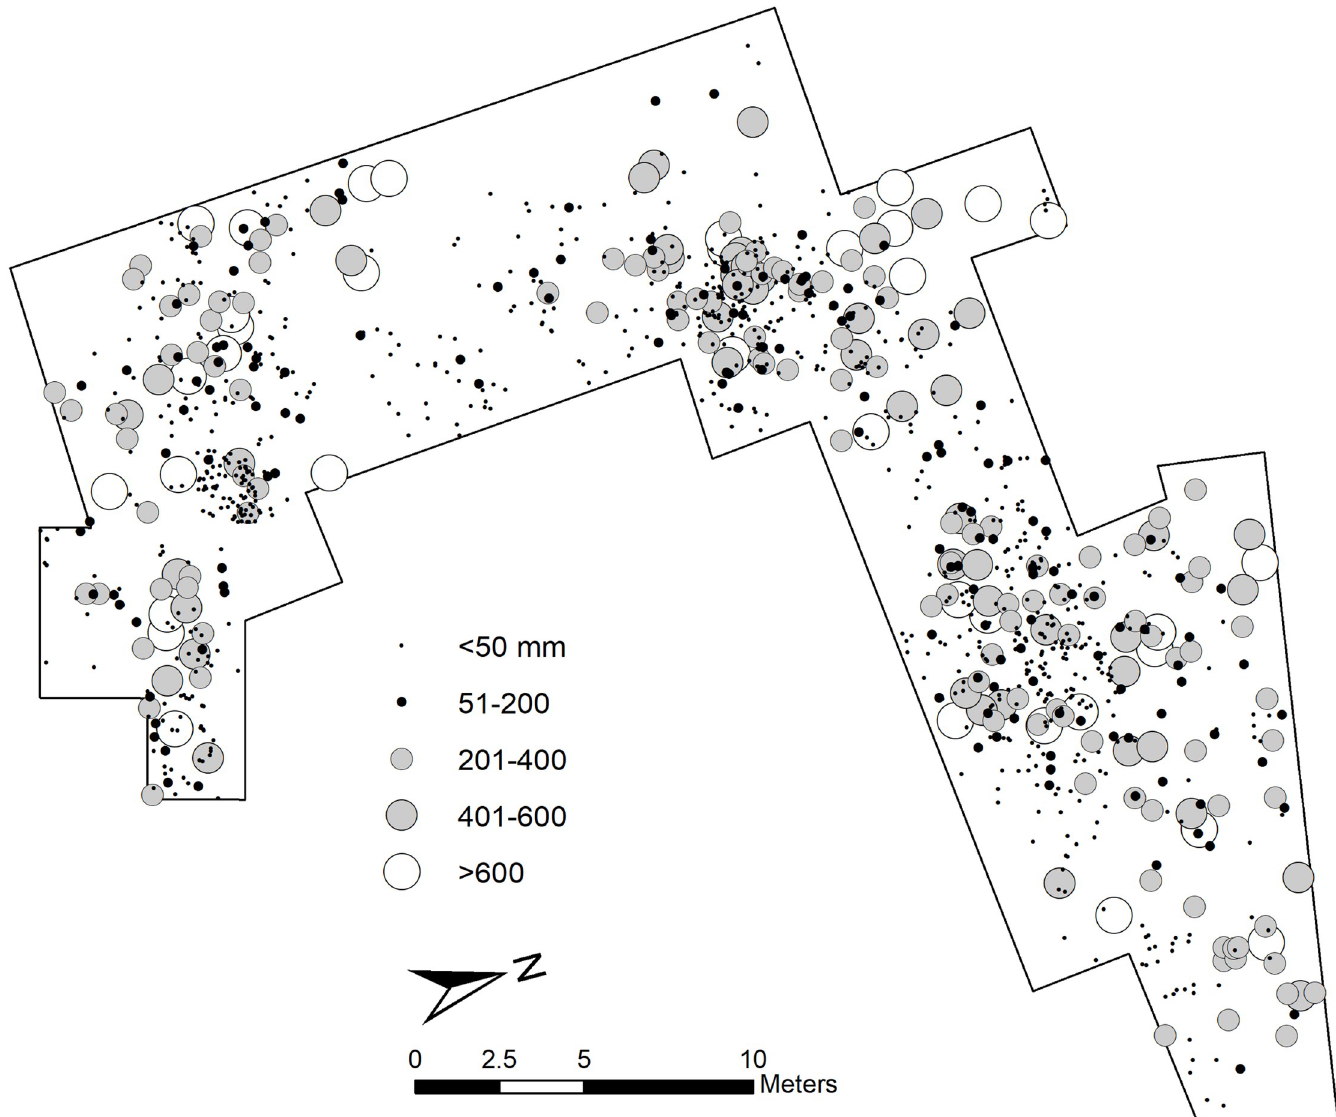
Fig 2. Distribution map of artifact mass (weight) classes at